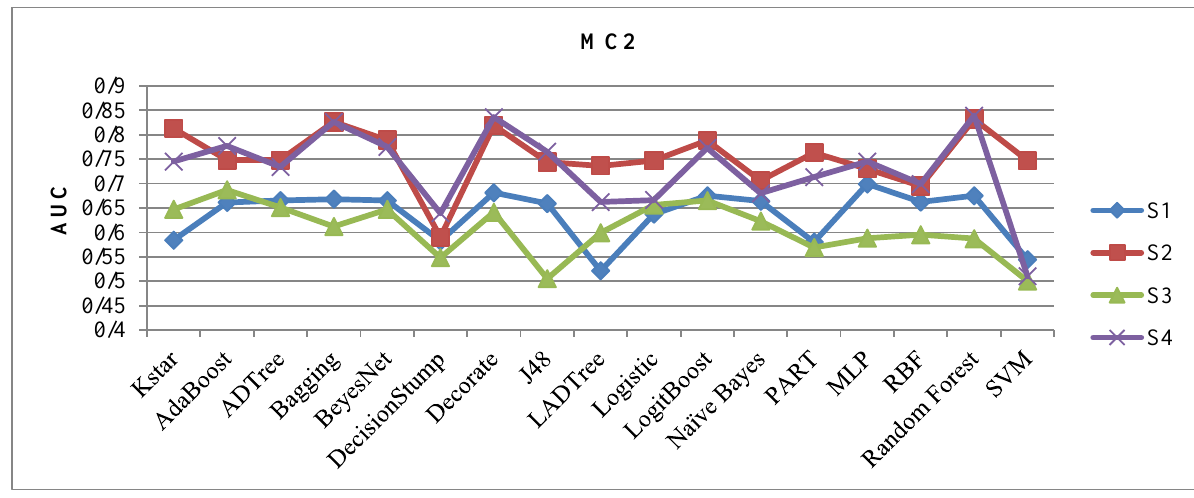
Figure 3. Performance evaluation of 17 data classifiers for MC1 dataset.